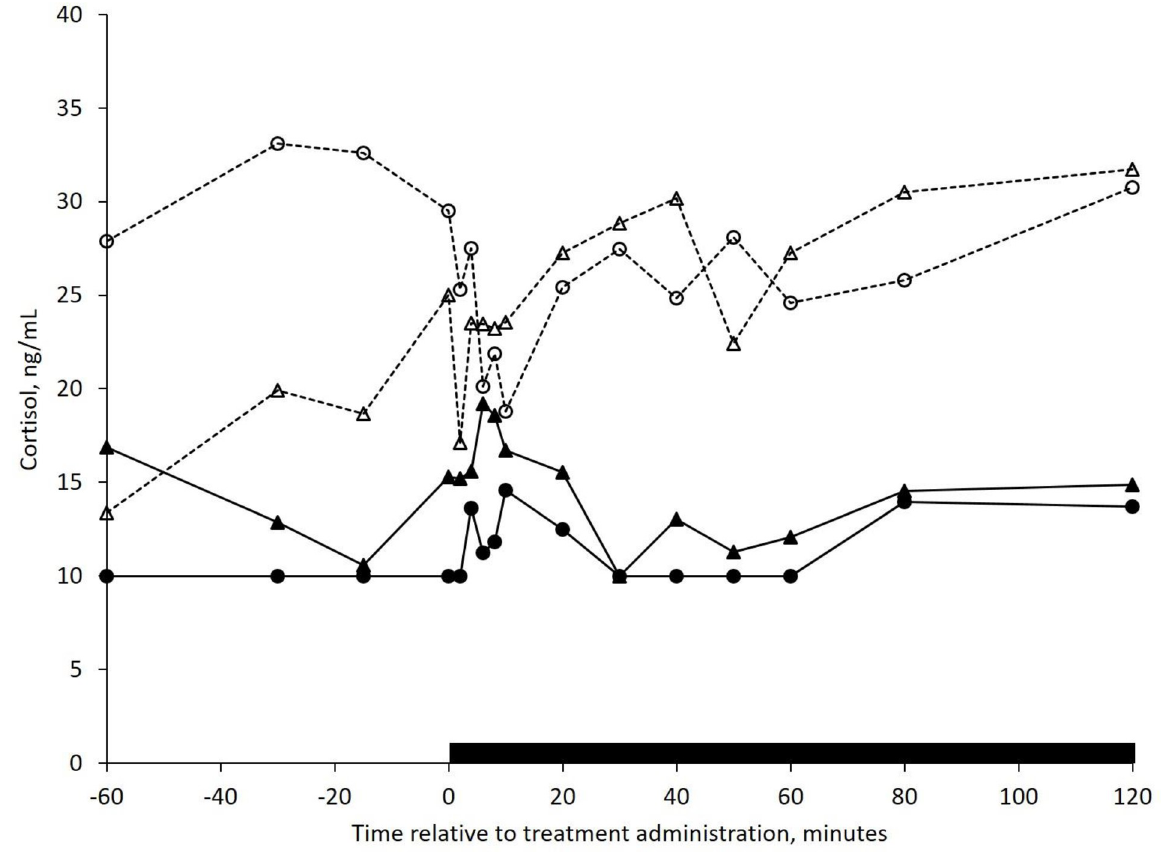
Fig 1. Mean plasma cortisol concentrations in Bostaurus cows assigned to one of the following treatment. s. 1) Non-lactating, saline (NL-S, – – Δ – –; n = 5), 2) Non-lactating, oxytocin (NL-OXT, – – � – –; n = 5); 3) Lactating, saline (L-S, ── ▲ ── ; n = 5); and 4) Lactating, oxytocin (L-OXT, ── ● ── ; n = 3). Intra-nasal treatments (S or OXT) were administered at 0 minutes and head restraint was applied for two hours (indicated by the black bar). Oxytocin was administered intra-nasally at a rate of 0.60 IU/kg bodyweight. The pooled SEM was 5.6. Only an effect of lactation ( P = 0.02) was detected (see Fig